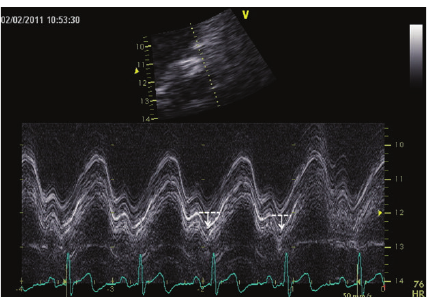
Figure 1: Representative M-mode tracing showing maximal mitral annular plane systolic motion. MA ascent (MAa) was measured as the distance of the annulus traversed from the end of diastasis until the end of atrial contraction (white arrow) from the imaginary line drawn (dotted white line) that represents annular motion during diastasis with the sharp ascent (downward slope) towards the atria after atrial contraction. Please note that typically several lines are always seen when performing M-mode of the MA due to the contribution of chordal structures. However, since these images have the same frequency, their reflected images maintain the same distance. Usually, the most reflective echo-bright image should be used for the purpose of measurements as shown in this figure. MAPSE is also